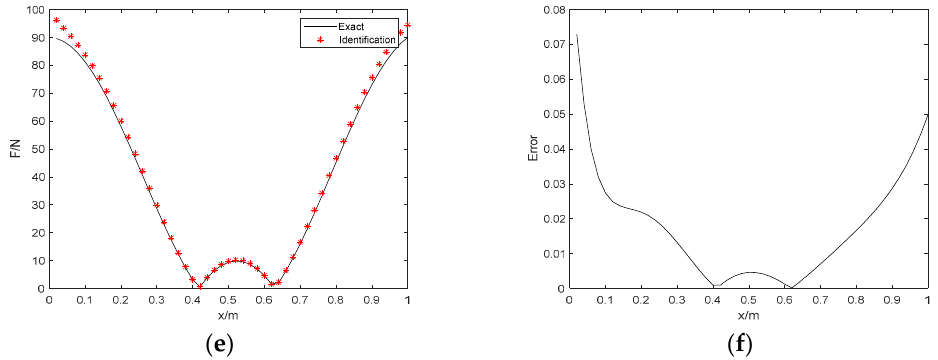
Figure 7. The identification results with 5% noise. ( a ) Proposed method; ( b ) identification error; ( c ) Tikhonov with L − curve regularization; ( d ) identification error; ( e ) Tikhonov with GCV regulariza- tion; ( f ) identification error.